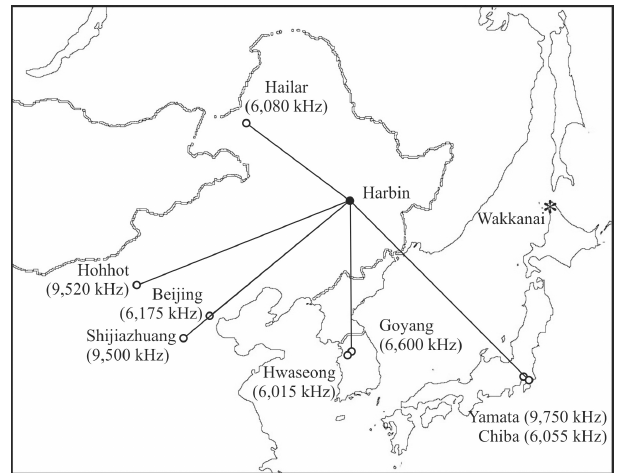
Figure 5. Layout of the propagation paths used for monitoring dy- namic processes operating in the